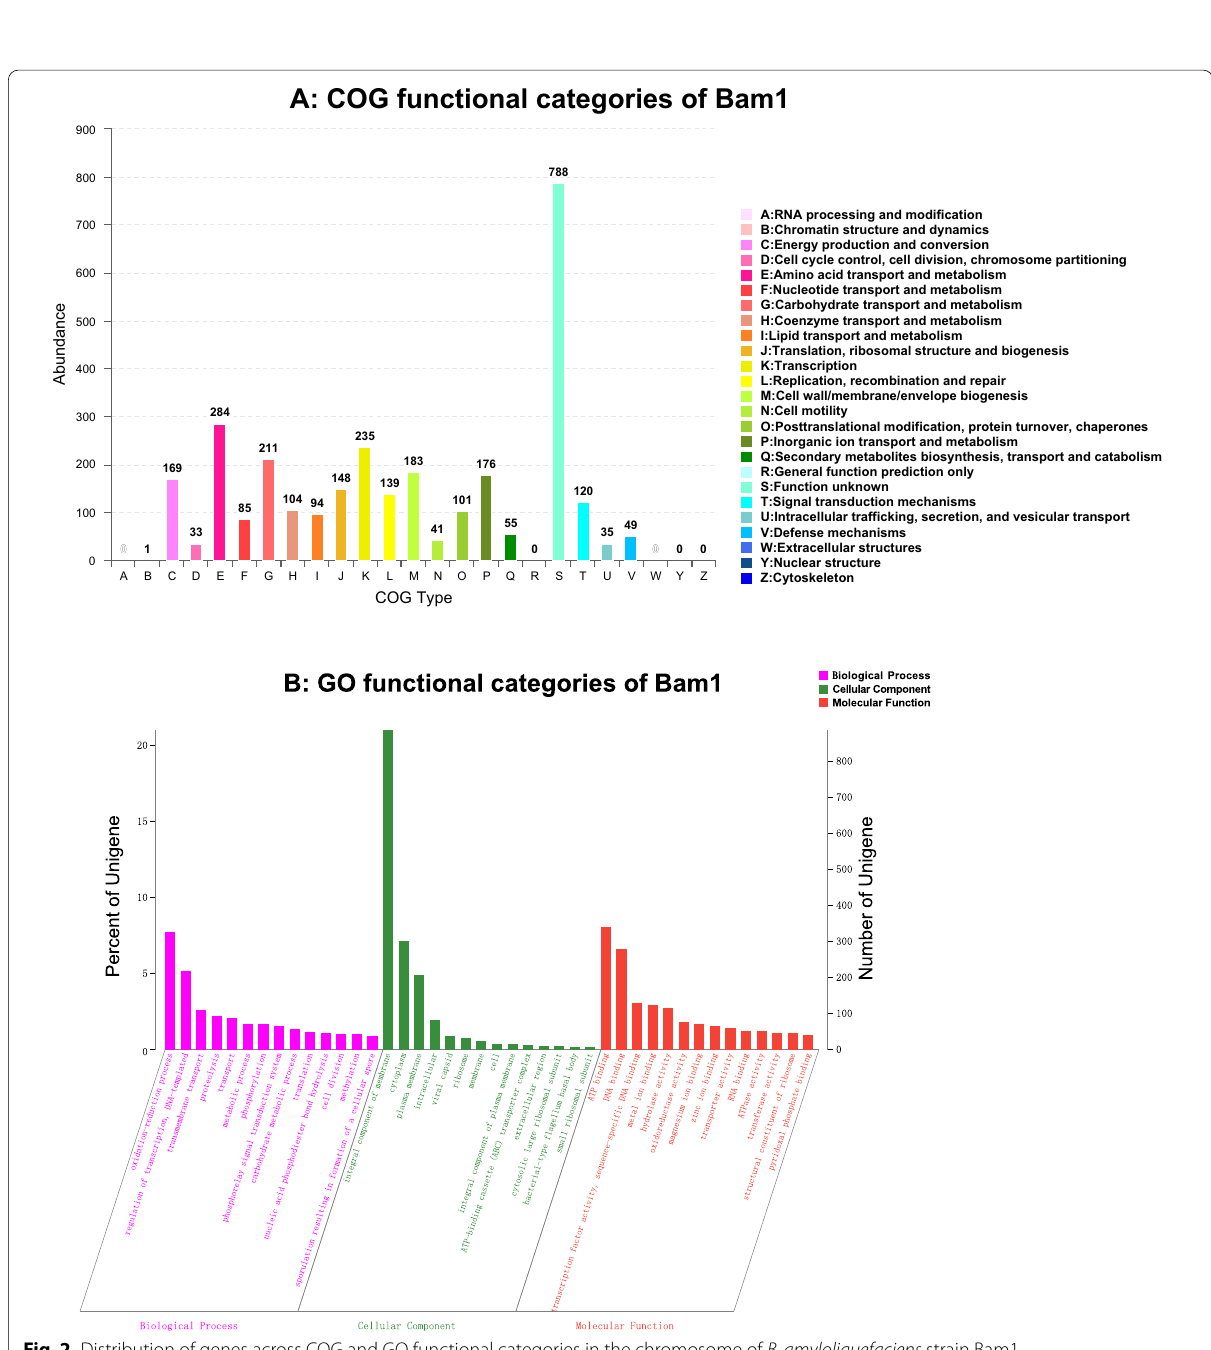
Genome comparison within the ten B. amyloliquefaciens strains and B. velezensis strain FZB42 The phylogenetic tree (Fig. 3) and pan-genome analy- sis (Fig. 4) were all performed between strains Bam1, B. velezensis FZB42 (commercialized PGPR and biocontrol